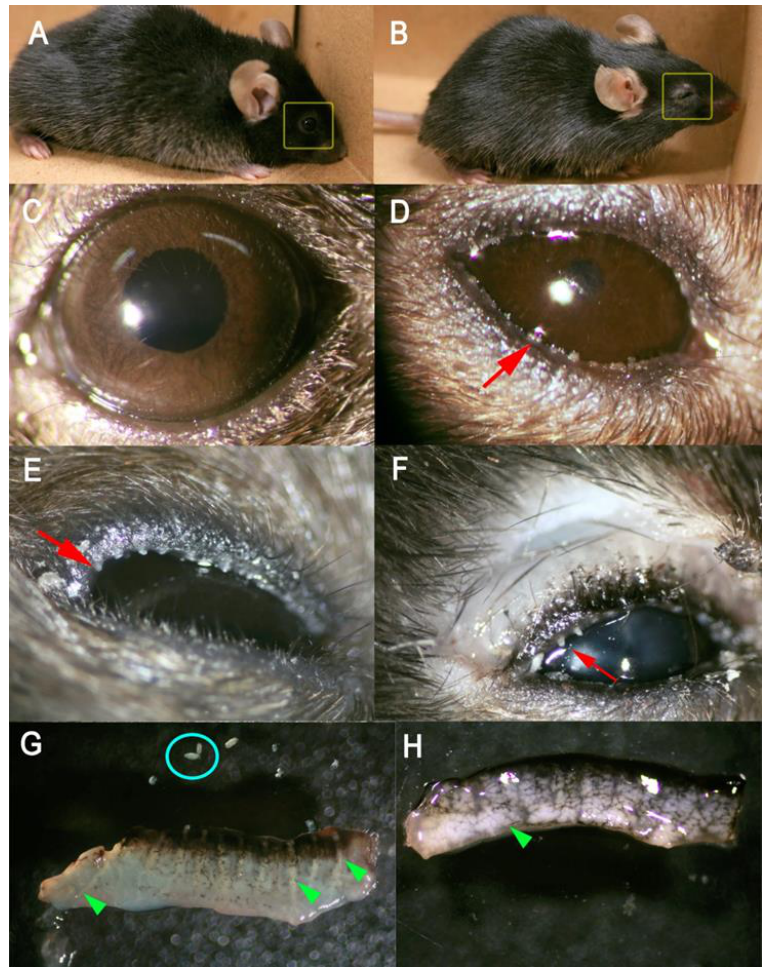
Figure 1. Characterization of ocular phenotype of Soat1 -null mice. ( A ) Wild-type male mouse with normal fur and normal eye opening (yellow box). ( B ) Soat1 -null male mouse with normal fur and slit eye opening (yellow box). ( C ) Slit lamp image of a normal mouse eye. ( D ) Soat1 -null slit lamp image with meibum accumulations around the eye (red arrow). ( E ) Pouting of Meibomian gland orifices of a Soat1 -null mouse (red arrow); ( F ) Thick meibum extruding from the orifices (red arrow) upon application of gentle pressure. ( G ) Excised Soat1 -null tarsal plate with visible ducts and indistinct acini (green triangle) and solidified meibum accumulations (blue circle). ( H ) Wild-type tarsal plate with distinct acini (green triangle).